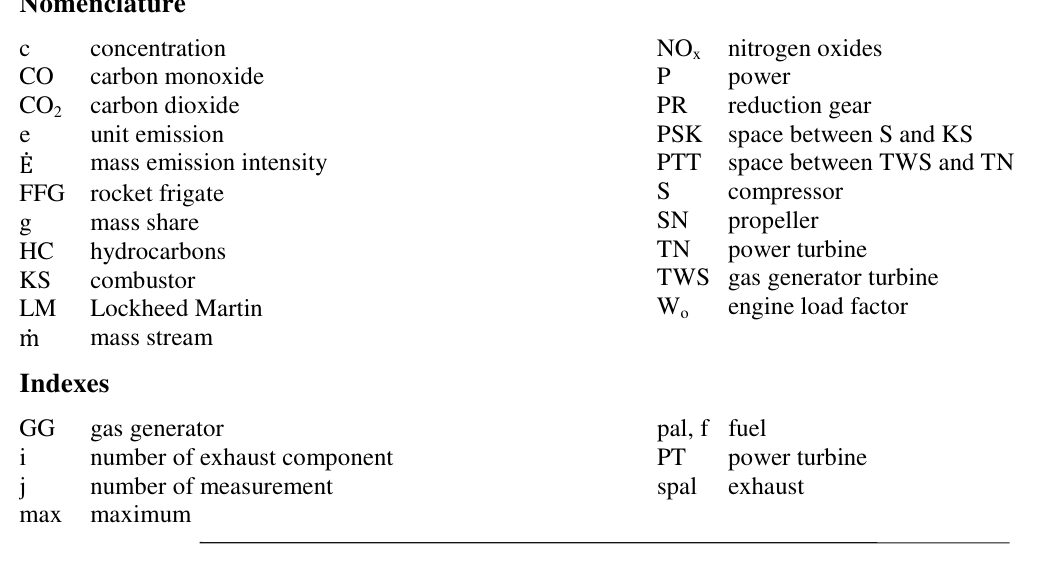
Fig. 12. The unit emission of nitrogen oxides ( e ( e ) in the LM 2500 1A and LM 2500 1B engines exhaust as a function -! of the engine load factor (W o